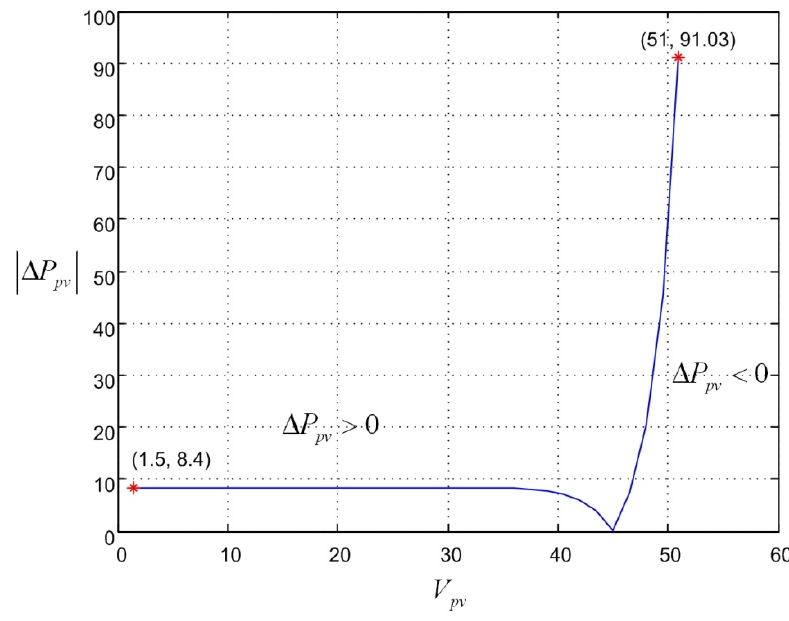
Figure 7. Concept for determining the MF setting values of the input variables ∆ P pv